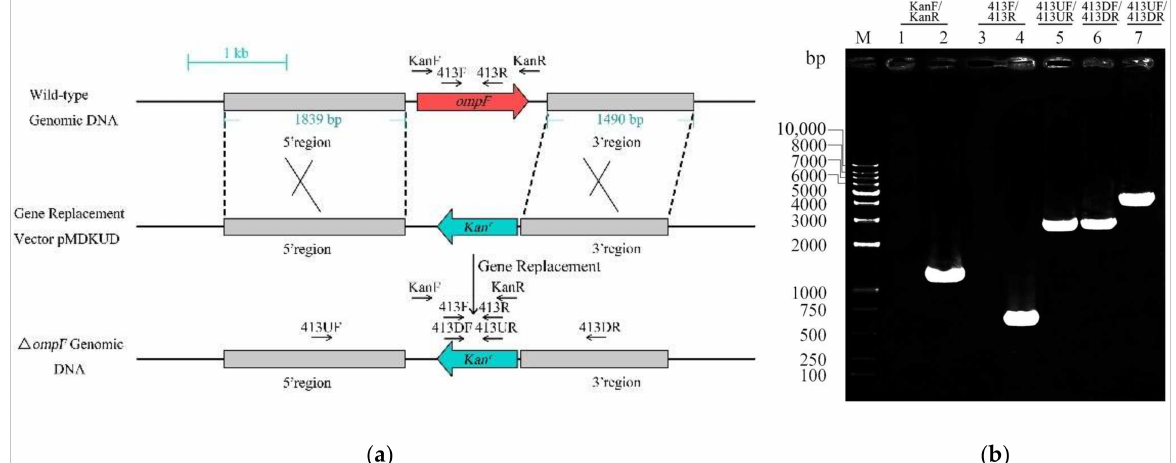
Figure 1. Construction and verification of the ompF deletion mutant. ( a ) Schematic representation of the ∆ ompF construction via homologous recombination. ( b ) Verification of ompF homologous recombination events. Lane M, DL10000 marker; lanes 1 and 2, amplified with KF/KR, WT and ∆ ompF as templates, respectively; lanes 3 and 4, amplified with 413F/413R, ∆ ompF and WT as templates, respectively; lane 5, amplified with 413UF/413UR, ∆ ompF as template; lane 6, amplified with 413DF/413DR, ∆ ompF as template; lane 7, amplified with 413UF/413DR, ∆ ompF as